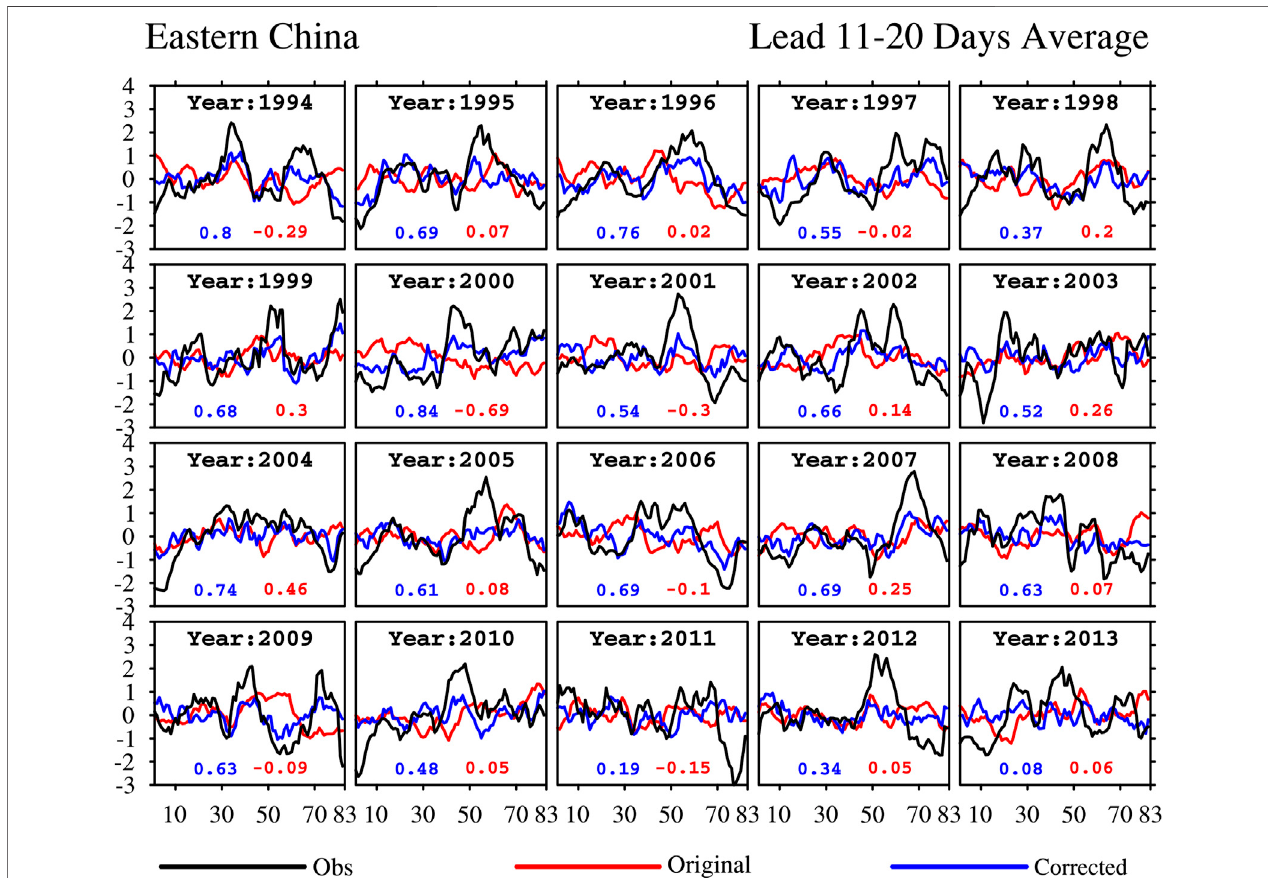
FIGURE 4 | Same as Figure 3 , but for the predictions with the forecast lead time of 11 – 20 days.